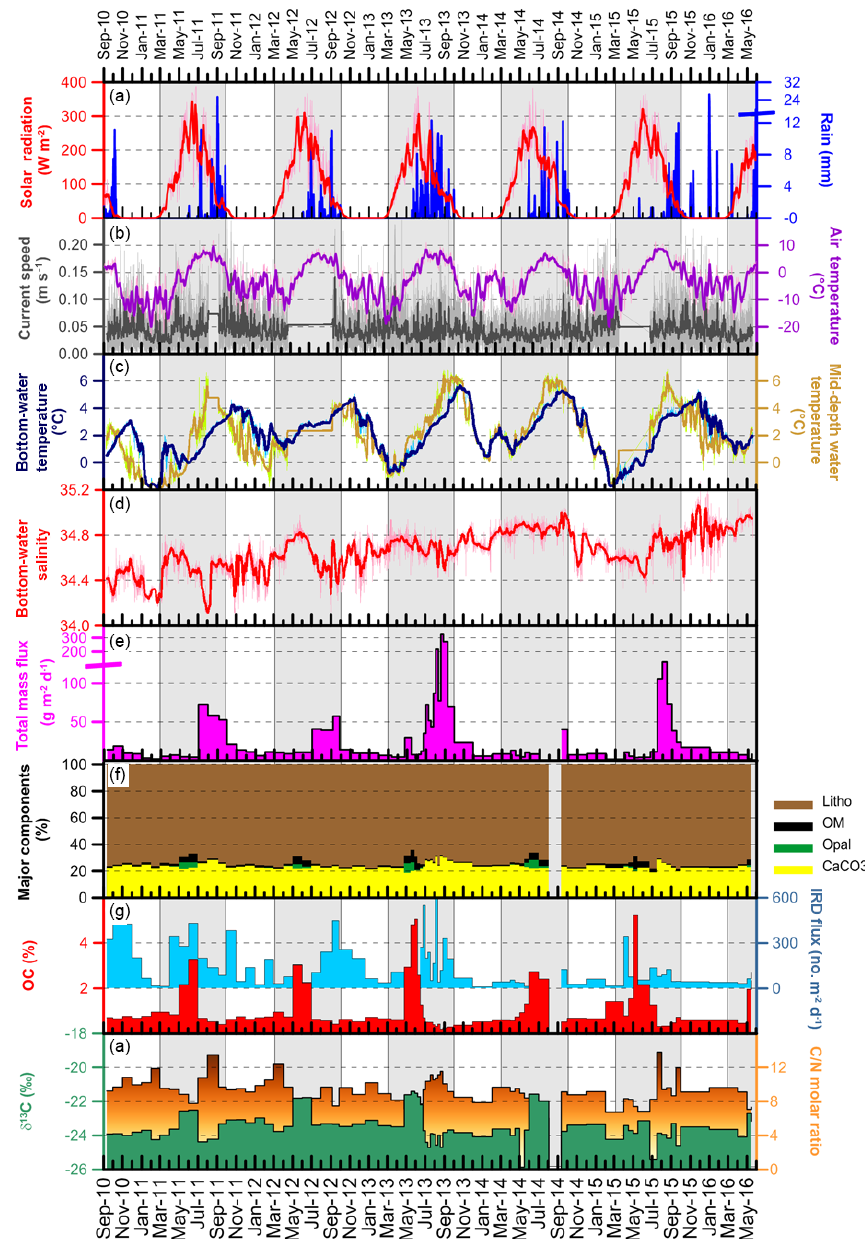
Figure 2. Time series of atmospheric and marine parameters recorded in Kongsfjorden between September 2010 and June 2016: (a) so- lar radiation and rain precipitation, (b) air temperature and mid-water current speed, (c) intermediate and near-bottom water temperature, (d) salinity at the near bottom, (e) total mass flux (TMF) particle fluxes, (f) particle composition, (g) contents of OC and IRD, and (h) C / N molar ratio and δ 13 C values measured on the organic fraction. Light grey bands depict the polar day of each year, characterized by enhanced solar radiation. Parameters with high-frequency temporal oscillations (solar radiation, air and water temperatures, salinity, current speed) were plotted with a superimposed week-running average (heavy